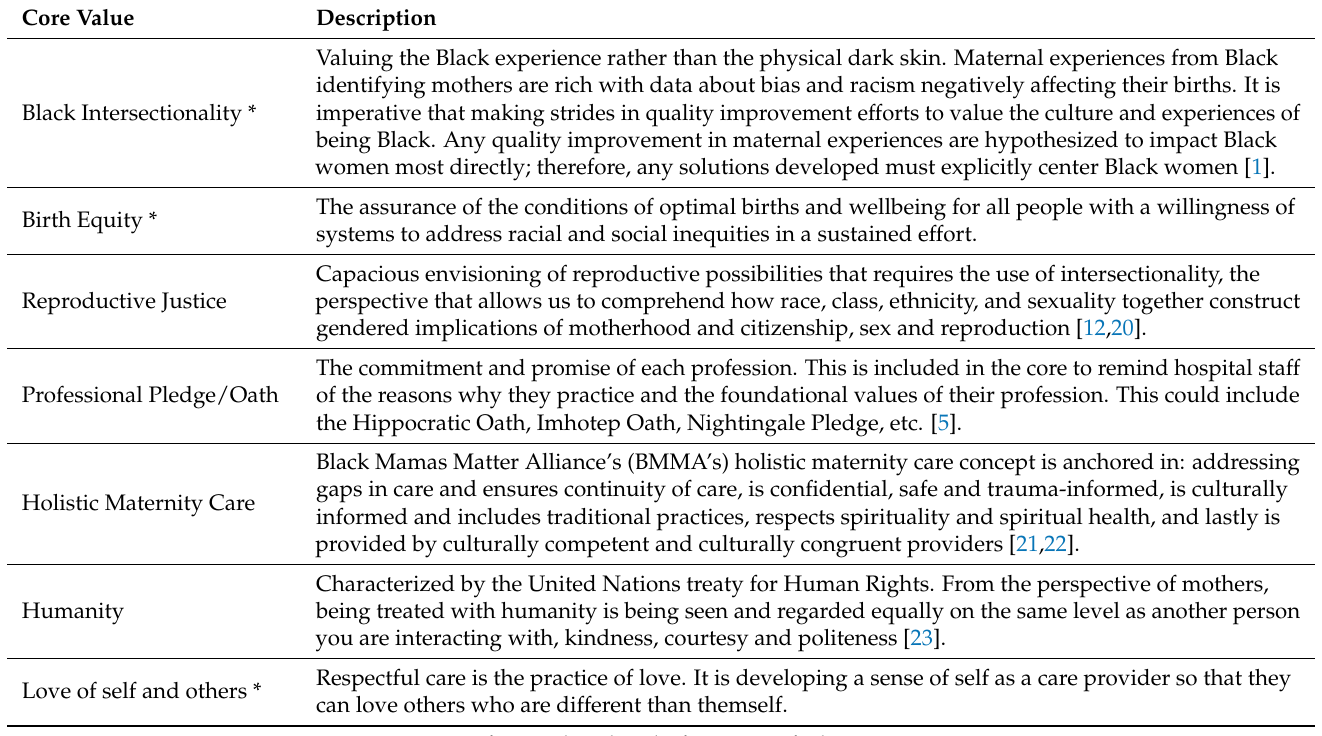
put into practice Table 3: Examples of Individuals Moving through the Cycle illustrates the process by which a physician, nurse, and patient might move through the cycle. See Table 4: Moving through the Cycle to Respectful Care for the rationale and evidence for each phase. Table 2. Definitions and Descriptions of the Core.